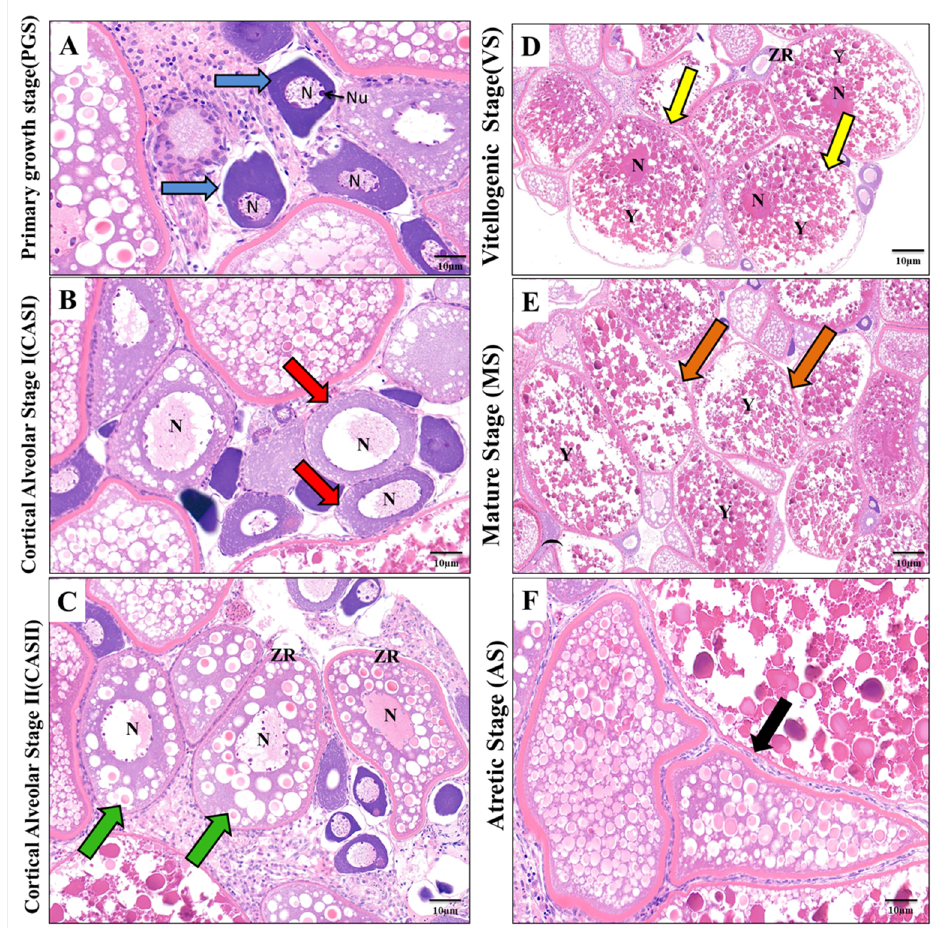
Figure 3. Histological structure showing the different stages of oocyte development in the control zebrafish ovary: ( A ) Primary growth stage (PGS) (blue arrow). ( B ) Cortical Alveolar Stage I (CASI) (red arrow). ( C ) Cortical Alveolar Stage II (CASII) (green arrow). ( D ) Vitellogenic Stage (VS) (yellow arrow). ( E ) Mature Stage (MS) (orange arrow). ( F ) Atretic Stage (AS) (black arrow). N: nucleus, Nu: nucleolus, Y: yolk, ZR: Zona radiata (H&E, 10 µm). 3.5. ZnO-NPs Induce Cytotoxicity and Autophagosome Formation at the Ultrastructural